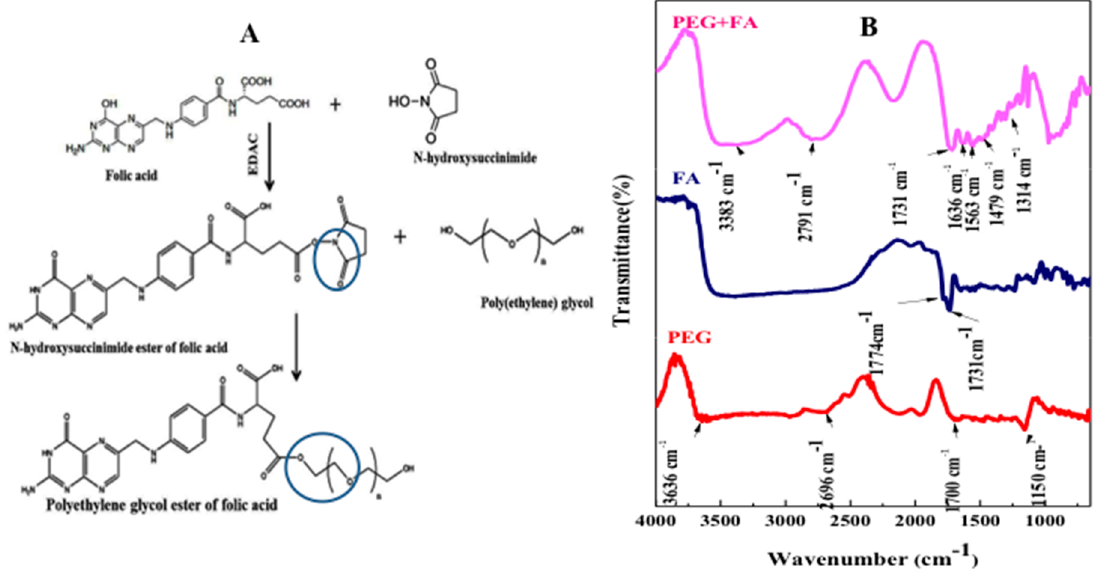
Figure 5. Folic acid conjugated with Poly (ethylene) glycol. ( A ) Scheme of FA-PEG conjugation; ( B ) FTIR spectra of PEG, PEG+FA, FA (arrows indicate selected bands).